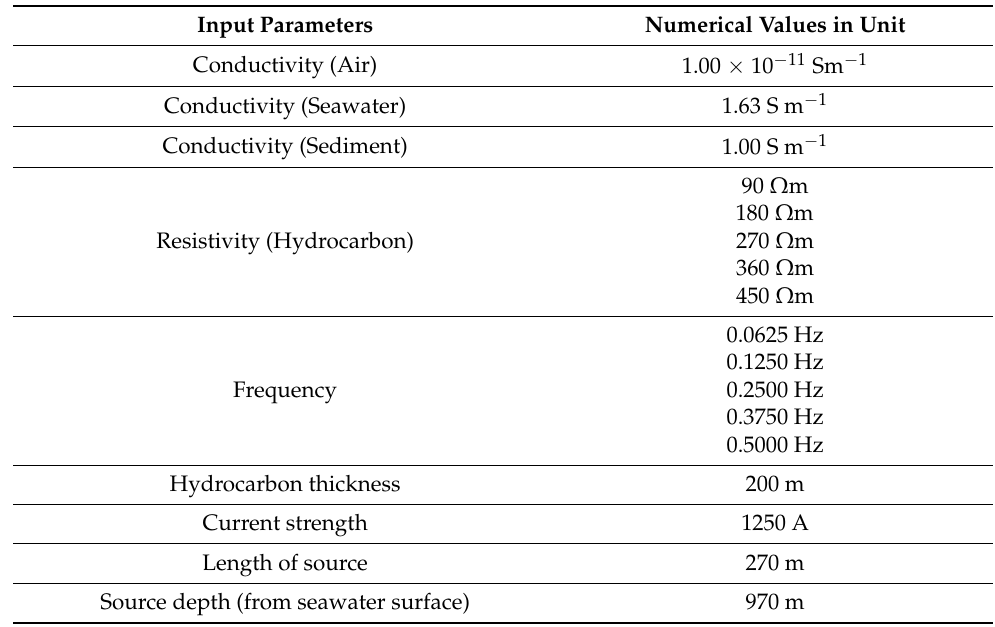
Table 1. Input parameters of the computer